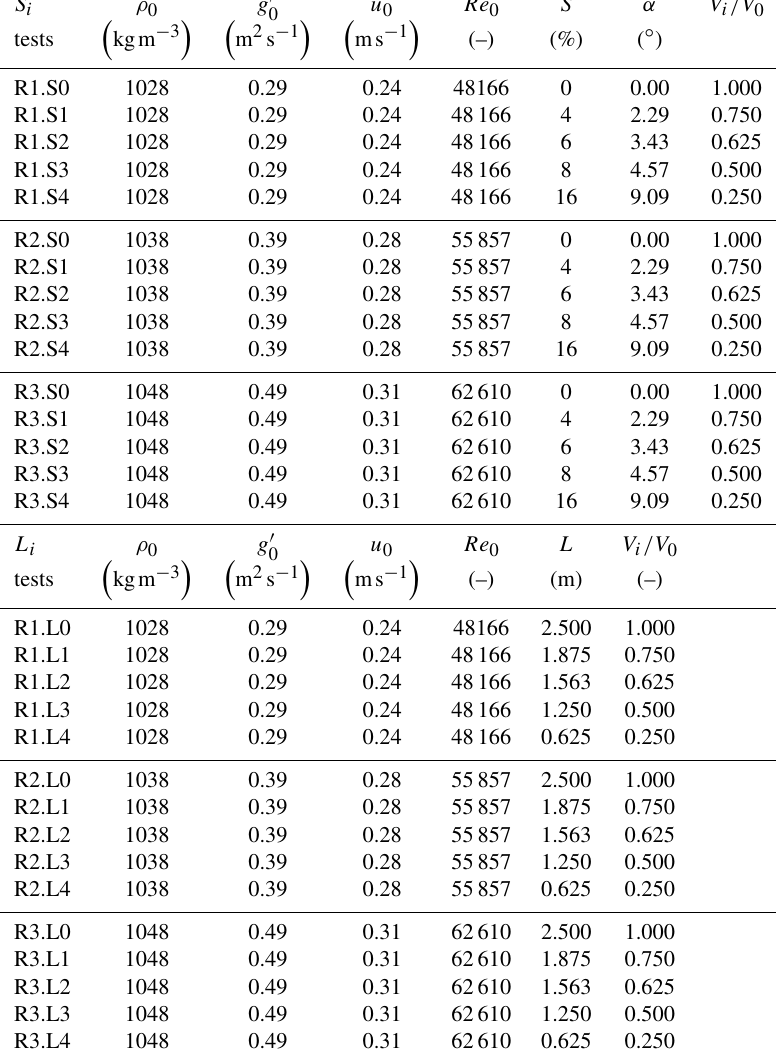
Table 1. Experimental parameters. ρ 0 is the initial density of the mixture in the upstream tank (measured with a densimeter), g (cid:48) is the reduced gravity corresponding to ρ 0 , Re 0 = u 0 h 0 /ν c is the Reynolds number based on initial quantities with u 0 = velocity, h 0 = 0 . 2m is the total height of the water column, ν c is the kinematic viscosity of the denser fluid, α is the angle of inclination of the bottom in the lock, S is the lock slope expressed in percentage ( h S lock reach and V i /V 0 is the percentage of volume of the upstream lock reach with respect to the configuration L 0